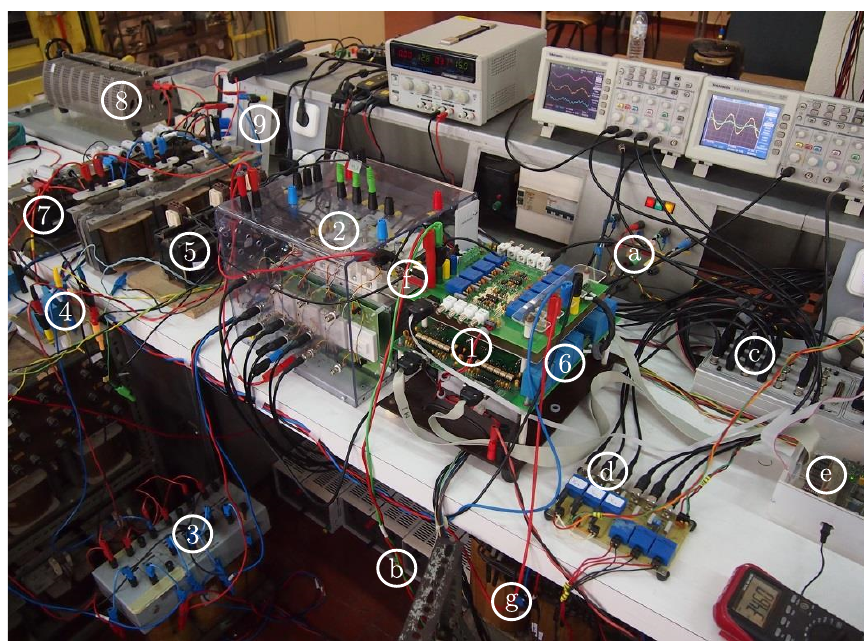
2 Matrix Converter (MC), (2) series converter or Figure 6. Experimental setup: (1) shunt converter or 3 × Voltage-Source Converter (VSC), (3) series transformer, (4) series filter capacitors, (5) series filter inductors, (6) shunt filter capacitors, (7) shunt filter inductors, (8) load resistor, (9) non-linear load diode full-bridge rectifier, (a) three-phase LV grid, (b) PV array emulator link, (c) dSPACE interface, (d) measurement board, (e) FPGA, (f) ‘dc link’, (g) isolation